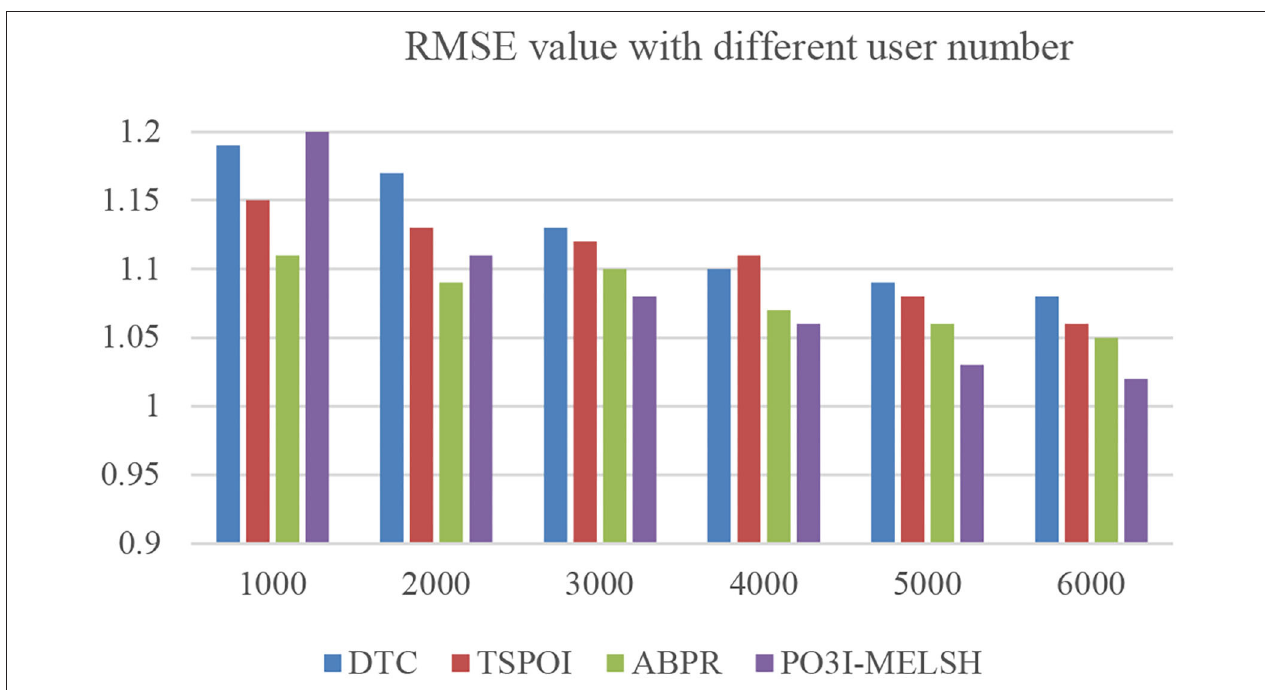
FIGURE 6 | Effect of user number on